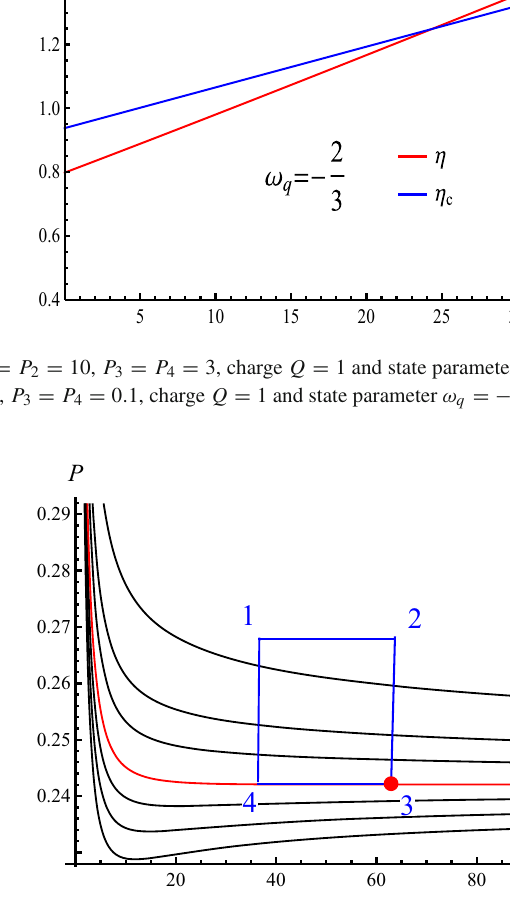
Fig. 12 The corner 3 of the engine cycle is placed at the critical point (i.e. T c = 0 . 0433, P c = 0 . 242 and V c = 61 . 56), and the red curve stands for the T = T c isotherm, here we take a = 2 , Q =